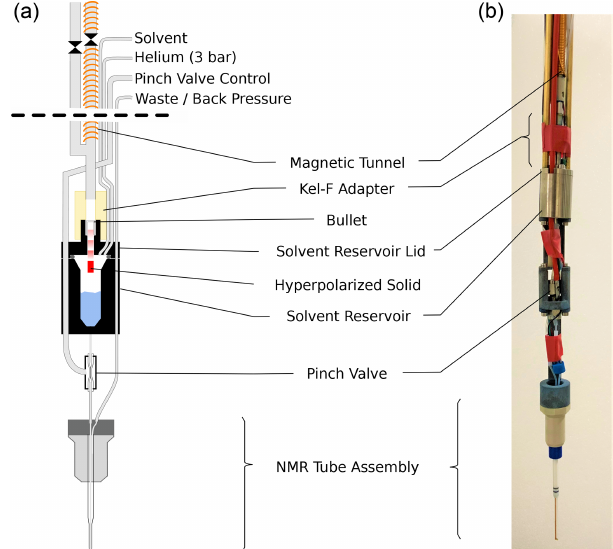
Figure 2. Sketch (a) and photograph (b) of the injection device. Prior to ejection the solenoid on the injection device sample tube is energized. The ball valve (shown between two sections of mag- netic tunnel) is opened and the bullet is ejected from the DNP insert. The bullet arrives via a central steel tube and comes to a stop at a constriction in the solvent reservoir lid. The hyperpolarized solid (red) passes through this constriction and dissolves in the solvent (blue) upon impact. The solvent reservoir is pressurized, and the pinch valve is opened, causing the liquid to flow into the NMR tube assembly via its inner capillary. After another delay, back pressure is applied to the exit line of the NMR tube assembly and NMR acquisition is started. The empty bullet may be ejected after the ex- periment by pressurizing the solvent